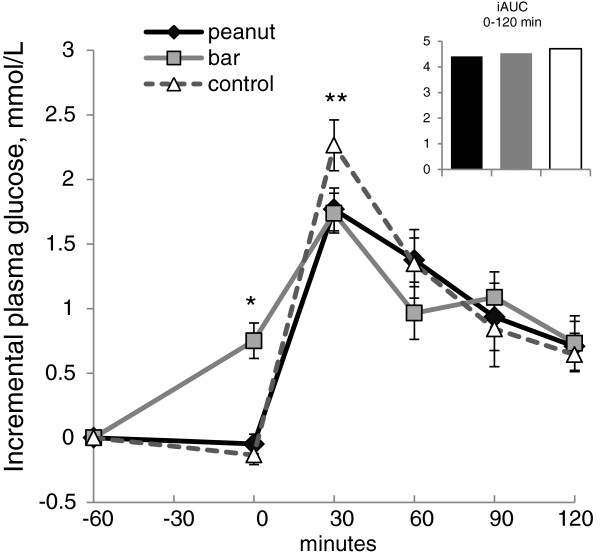
Incremental serum glucose for the acute trial (mean ± SE; n = 15). At time 0 the test meal was consumed, which was exactly one hour after ingestion of the control treatment (1 c water) or the peanut or grain bar treatment, each with 1 c water. Incremental plasma glucose curves differed significantly (repeated measures ANOVA, time x group interaction; p = 0.023). The incremental area-under-curve for 0–120 minutes did not differ by treatment (see inset; p = 0.901). * glucose excursion for grain bar significantly greater than that for peanut or control (p < 0.001). ** glucose excursion for control significantly greater than that for peanut or grain bar (p < 0.05).